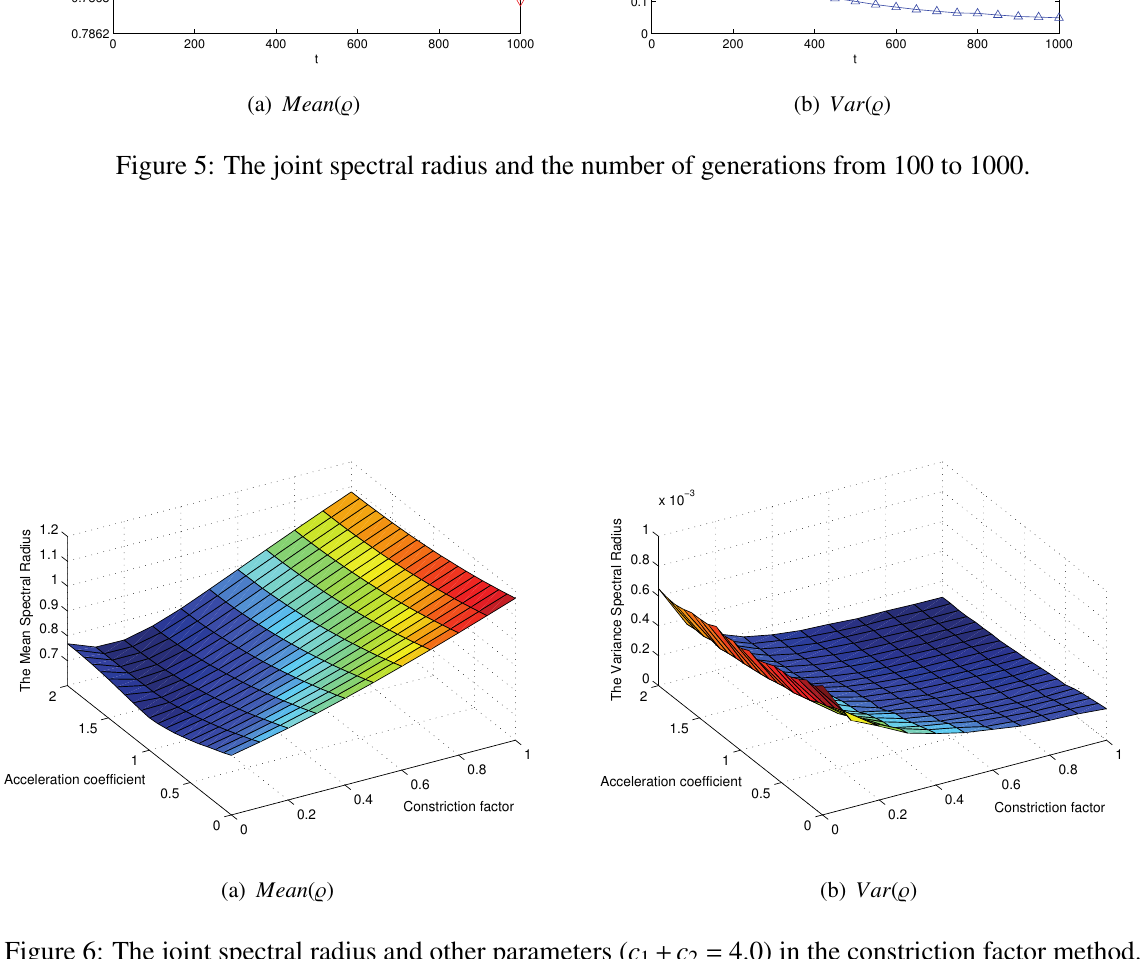
Figure 6: The joint spectral radius and other parameters ( c 1 + c 2 = 4 . 0) in the constriction factor